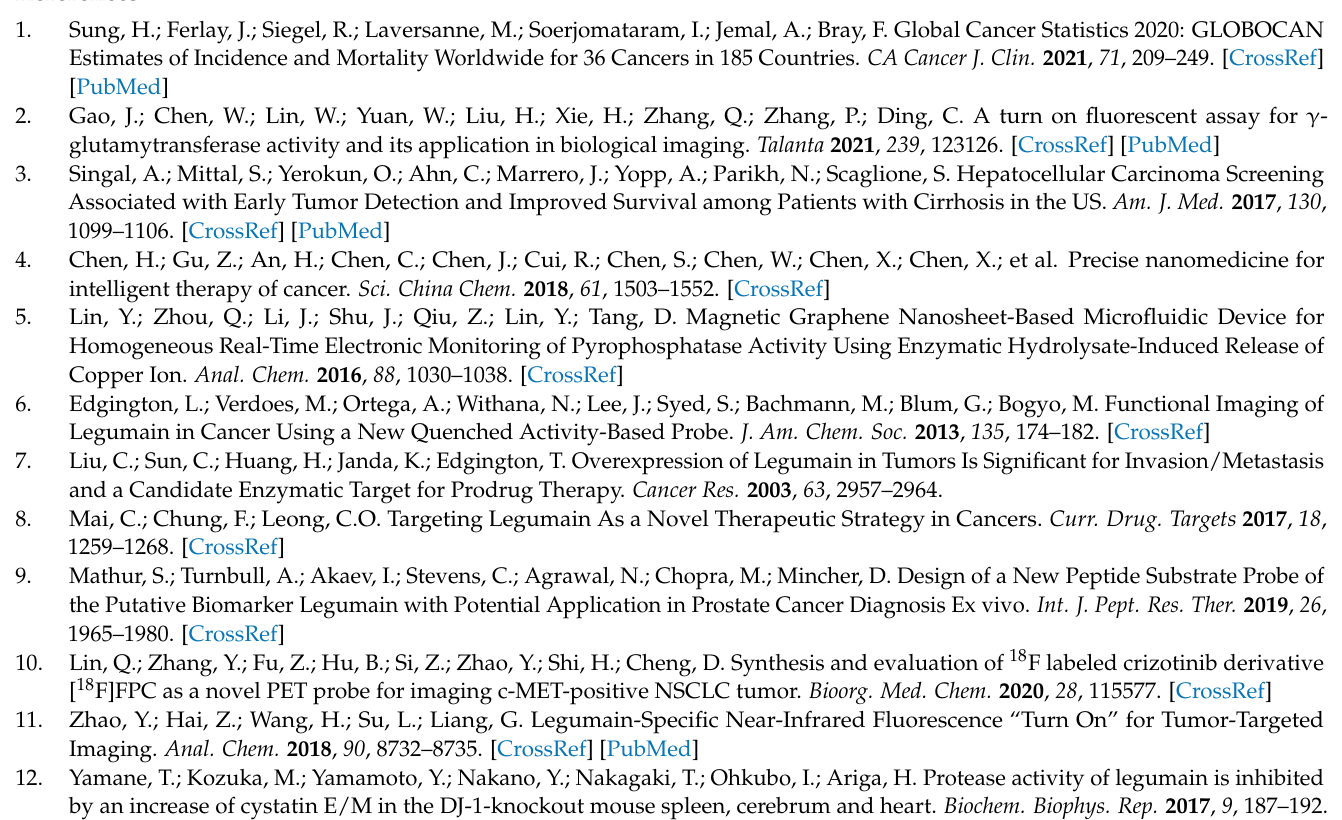
SF-12 , Figure S4: HPLC trace of compound SF-13 , Figure S5: ESI-MS of compound SF-13 , Figure S6: HPLC trace of nonradioactive probe [ 19 F] SF-AAN , Figure S7: ESI-MS of nonradioactive probe [ 19 F] SF-AAN , Figure S8: 1 H-NMR of nonradioactive probe [ 19 F] SF-AAN , Figure S9: 13 C-NMR of nonradioactive probe [ 19 F] SF-AAN , Figure S10: ESI-MS of compound [ 19 F] SF-AAN-R , Figure S11: ESI-MS of compound [ 19 F] SF-R , Figure S12: ESI-MS of compound [ 19 F] SF-C , Figure S13: cytotox- icity assay of nonradioactive probe [ 19 F] SF-AAN , Figure S14: pharmacokinetics of [ 18 F] SF-AAN , Figure S15: (A) Biodistribution of [ 18 F] SF-AAN in MDA-MB-468-bearing mice, (B) H&E staining, Table S1: HPLC conditions for analysis of all compounds, Table S2: HPLC conditions for purification of nonradioactive probe [ 19 F] SF-AAN